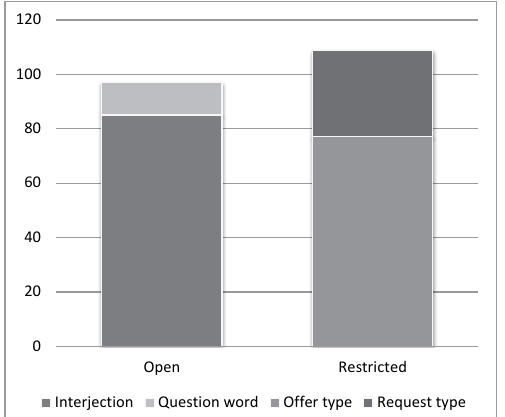
Open. ‘Open’ repair initiators are requests indicate some problem with the prior talk while leaving open what or where the problem is